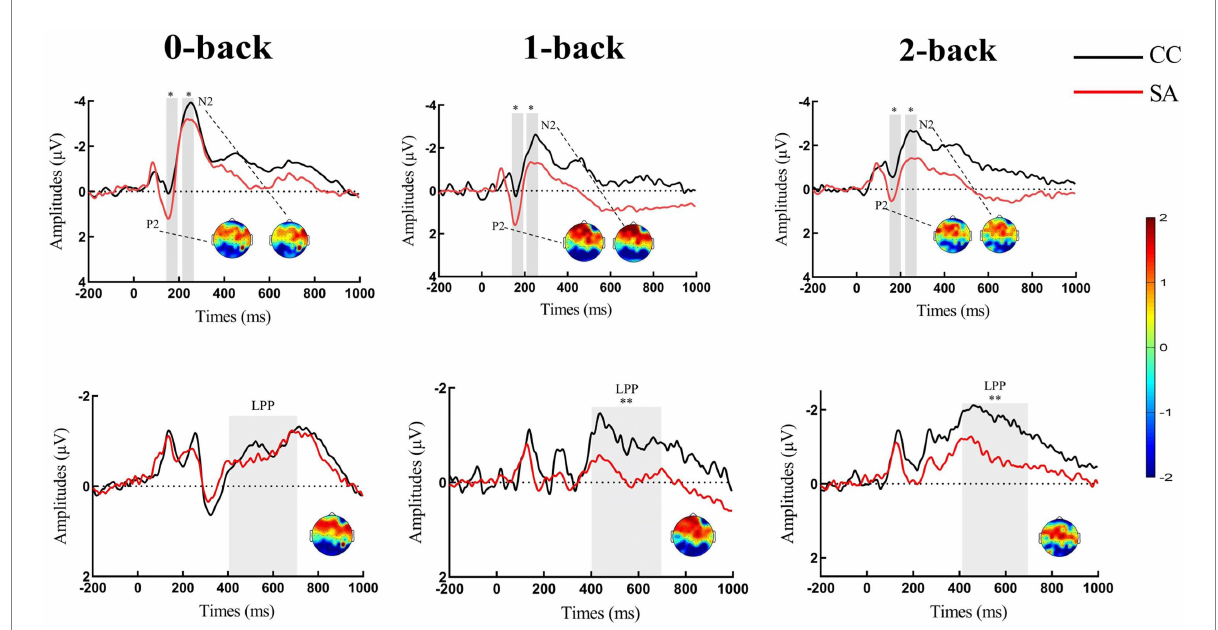
FIGURE 3 Grand-averaged event-related potential waveforms for P2/N2 and LPP of n-back task in self-awareness and control groups. Fz and FCz were selected for P2 (shaded: 150–200 ms time window) and N2 (shaded: 215–265 ms time window). FCz/Cz and CPz were selected for LPP (shaded: 400–700 ms time window). Scalp topographies of n-back task in self-awareness and control groups were come from difference waveforms (SA- CC) which were selected from a time window of 150–200 ms for P2, 215–265 ms for N2, and 400–700 ms for LPP. Please note that the positive- going component is plotted on the lower side of the y-axis, while the negative-going component is plotted on the upper side of the y-axis. * p < 0.05; ** p < 0.01. Red line represents participants of self-awareness group (SA), and black line represents participants of control group (CC).